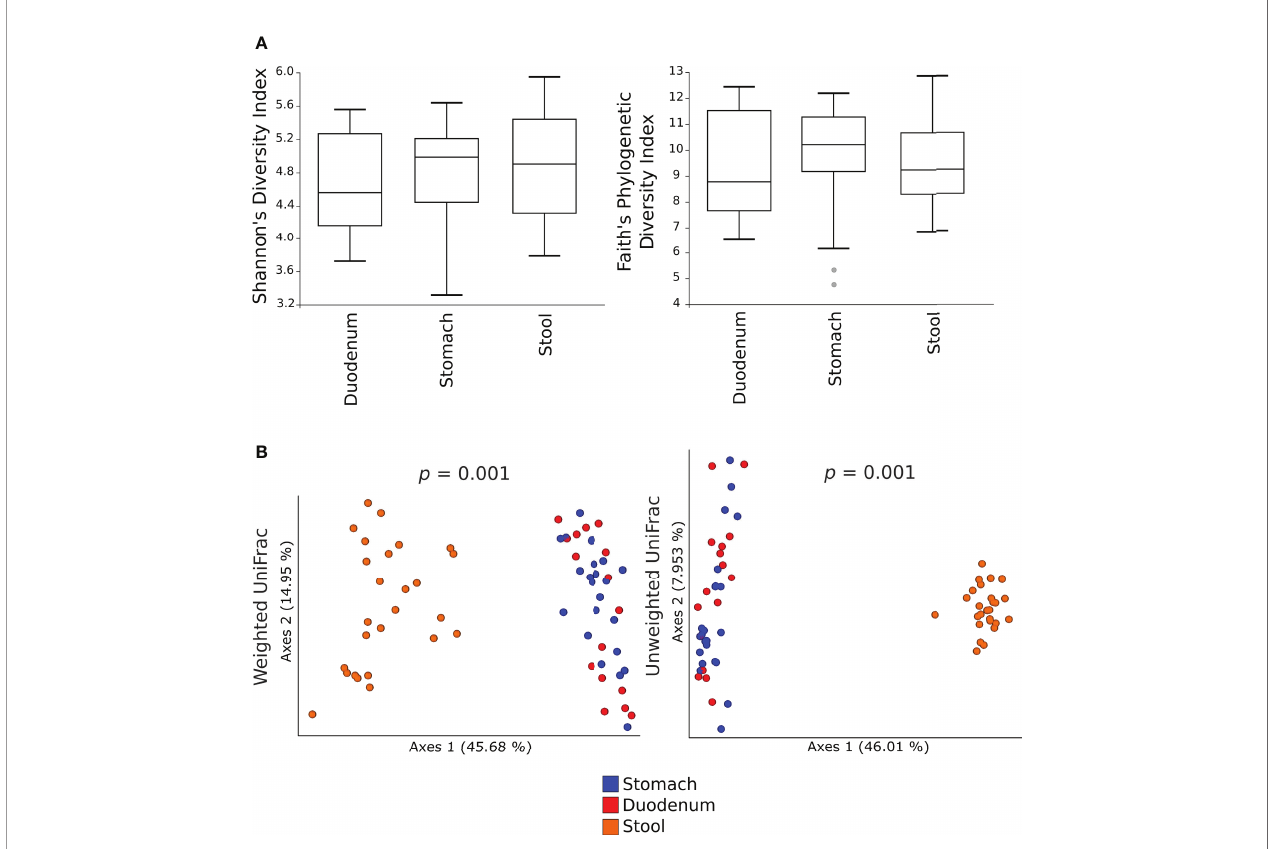
FIGURE 1 | Alpha- and beta- diversity of the microbial communities in gastric, duodenal, and faecal samples. Shannon ’ s diversity and Faith ’ s phylogenetic diversity indexes were used as measure of alpha-diversity within groups (A) . Samples were rare fi ed to the smallest observed number of reads (1257 for gastric biopsies, 931 for duodenal biopsies and 2935 for faecal samples). The circles out of the range represent the outliers; Principal coordinate analysis (PCoA) plots of weighted and unweighted UniFrac distances are represented (B) . Each dot represents the bacterial community composition of one individual at each anatomical site. Groups were compared using Adonis for beta